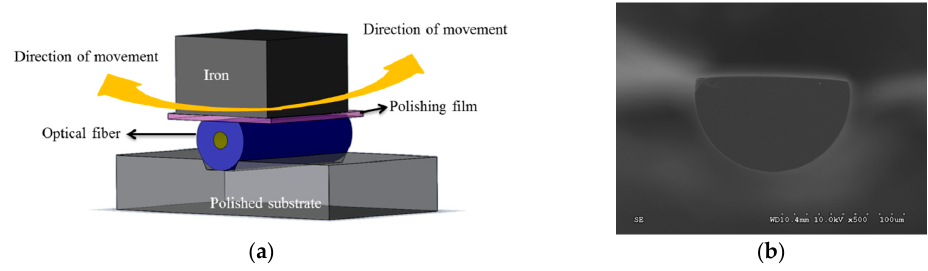
Figure 1. ( a ) Framework for polishing the optical fibers; and ( b ) cross-sectional image of a polished fiber.